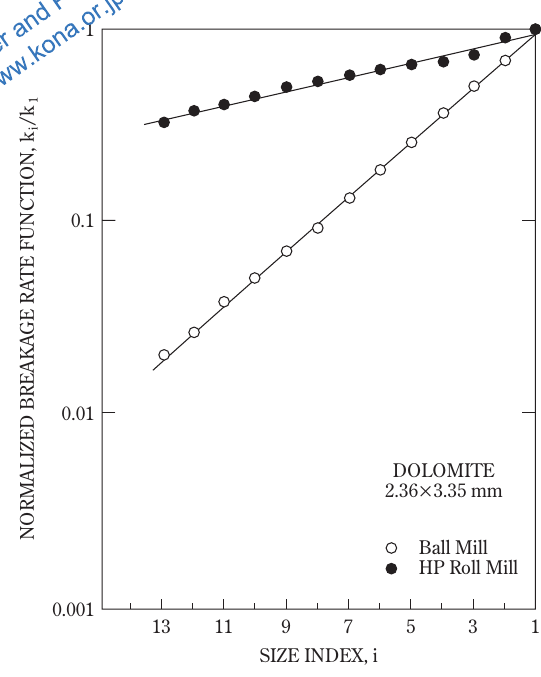
Fig. 7 The effect of particle size on the estimated breakage rate functions for dolomite being ground in the high-presssure roll mill and a ball mill (size index 1 (cid:3) 8 (cid:4) 10 mesh here).